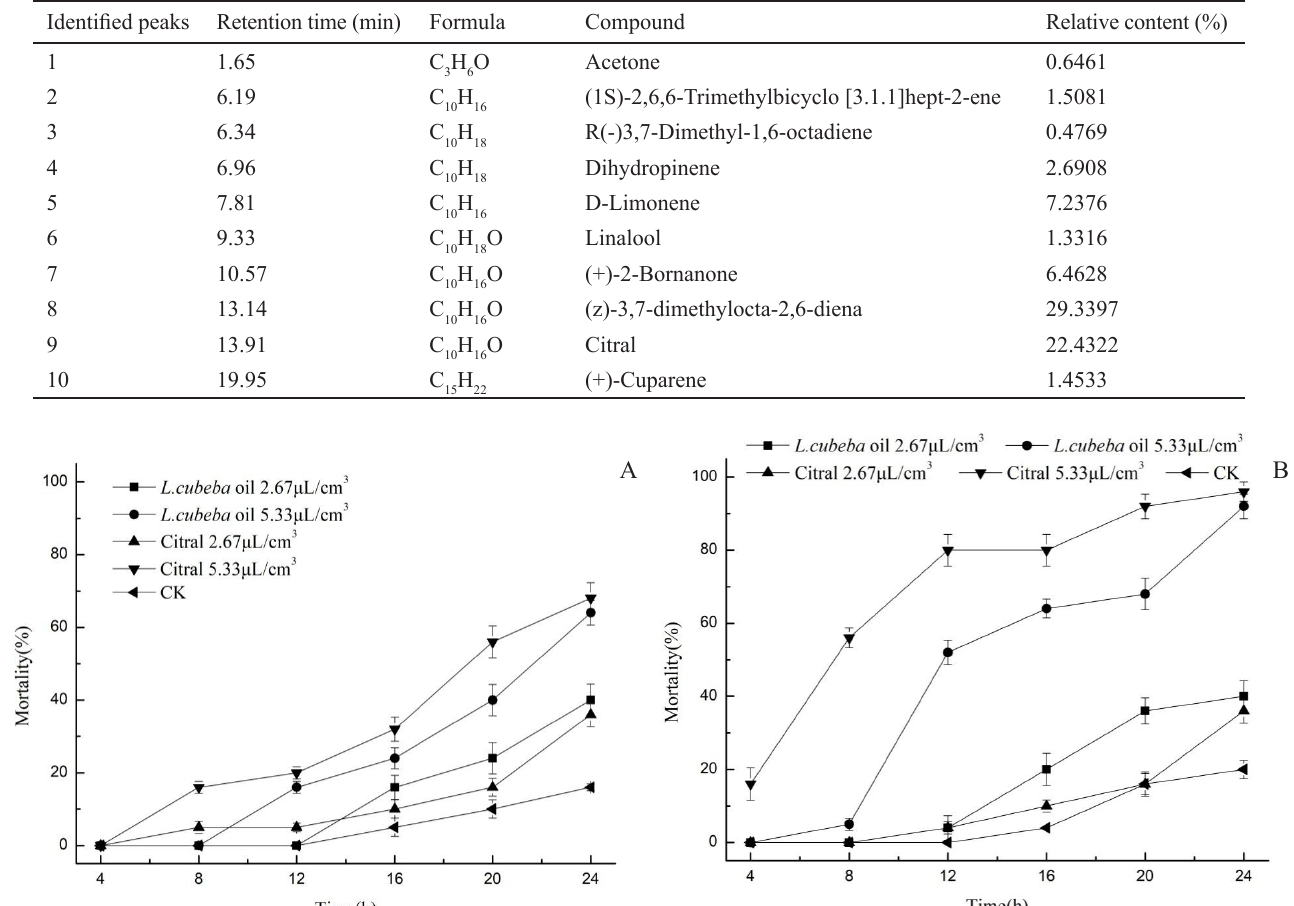
Table 2 . Volatile components of Litsea cubeba